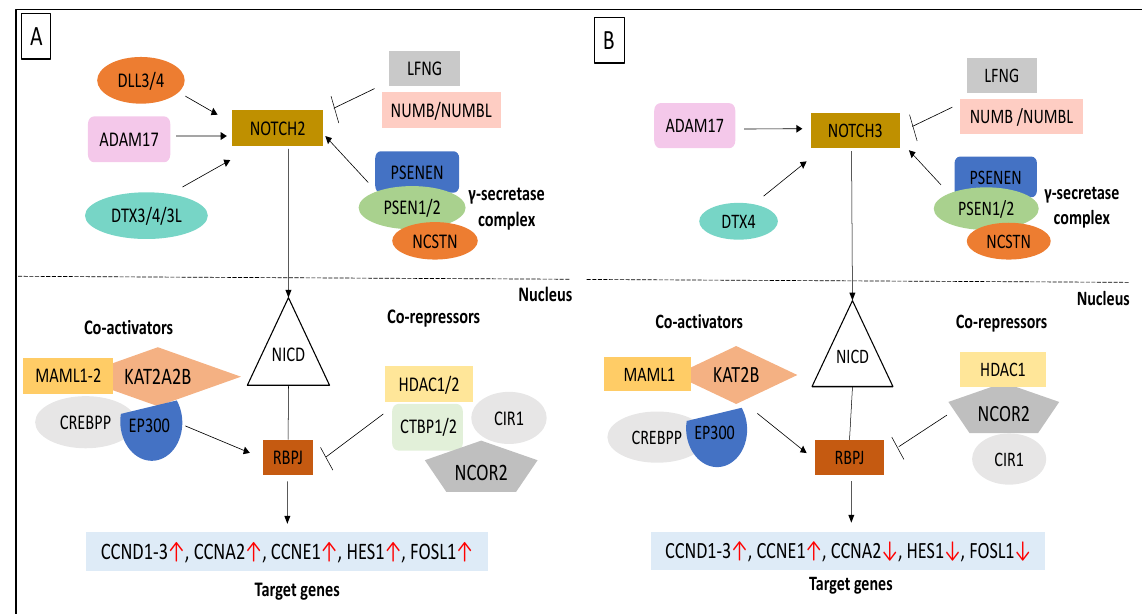
Figure 9. Notch signalling pathway in ( A ) AM-MSCs and ( B ) WJ-MSCs after osteogenic induction. Symbol ↑ , ↓ and ׀˗˗˗ represent upregulation, downregulation and inhibition, respectively. NICD: Notch intracellular domain.